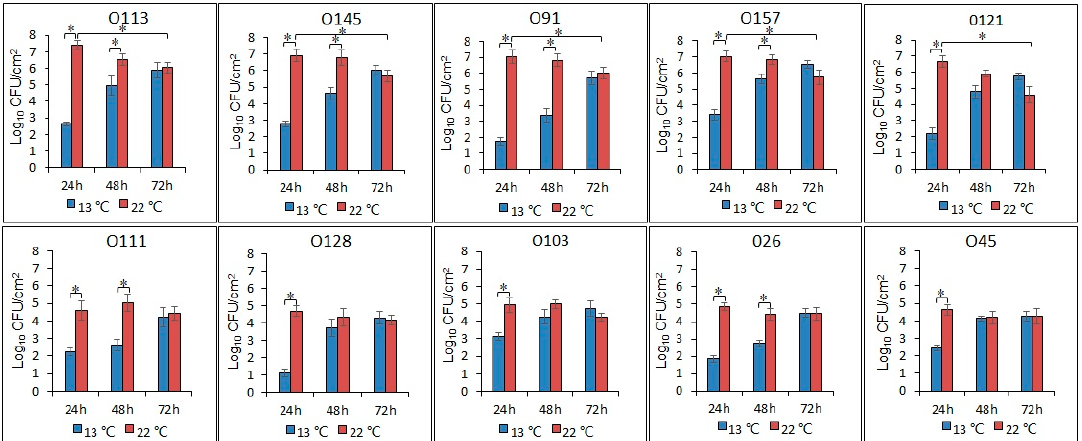
Figure 2. Number of biofilm cells of the 10 STEC isolates after incubation at 22 °C and 13 °C for 24, 48, and 72 h. Asterisk denotes a significant difference ( P < 0.05).